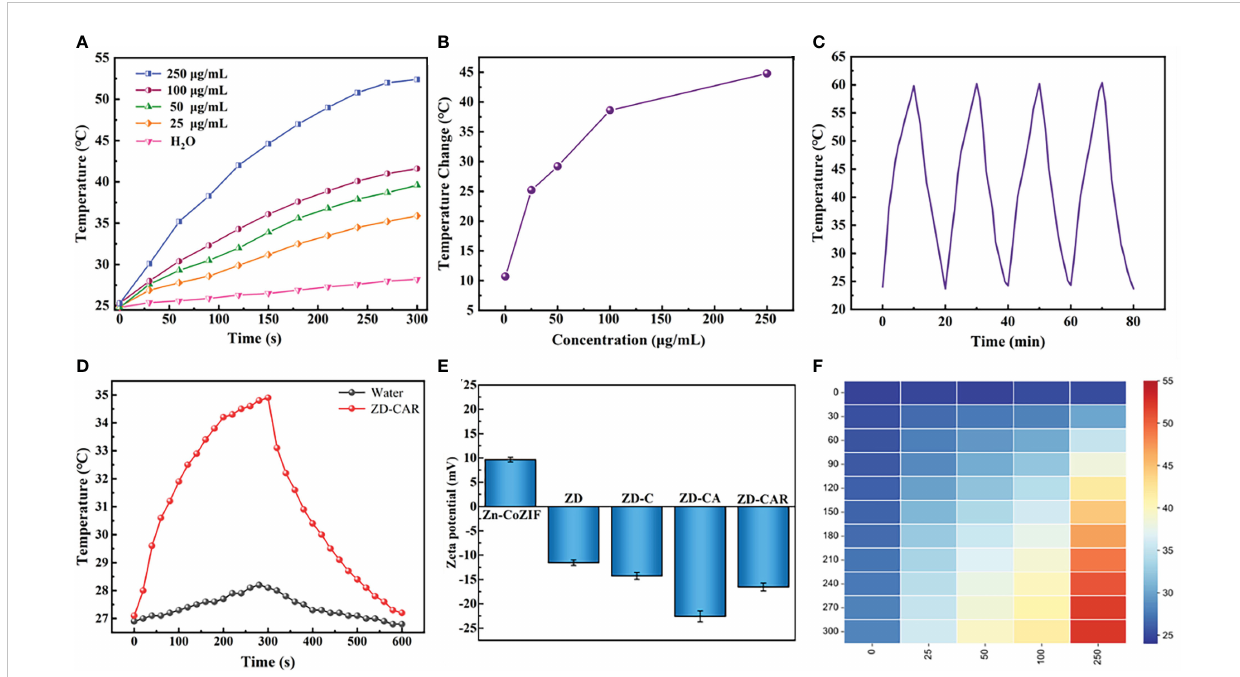
FIGURE 5 (A) Temperature changes of ZD-CAR with different concentrations under 808 nm laser irradiation (2W·cm − 2 ). (B) Temperature changes of ZD-CAR with different concentrations under 808 nm laser irradiation for 10 min (2W·cm − 2 ). (C) Recycling heating curves of ZD-CAR (1mg·mL − 1 ) with laser (2W·cm − 2 ). (D) Heating and cooling curves of water and ZD-CAR under 808 nm laser (2W·cm − 2 ). (E) Zeta potential of Zn-Co ZIF, ZD, ZD-C, ZD-CA and ZD-CAR at 200 m g/mL. (F) Heat map of ZD-CAR for temperature changes of ZD-CAR with different concentrations under 808nm laser irradiation (2W·cm − 2